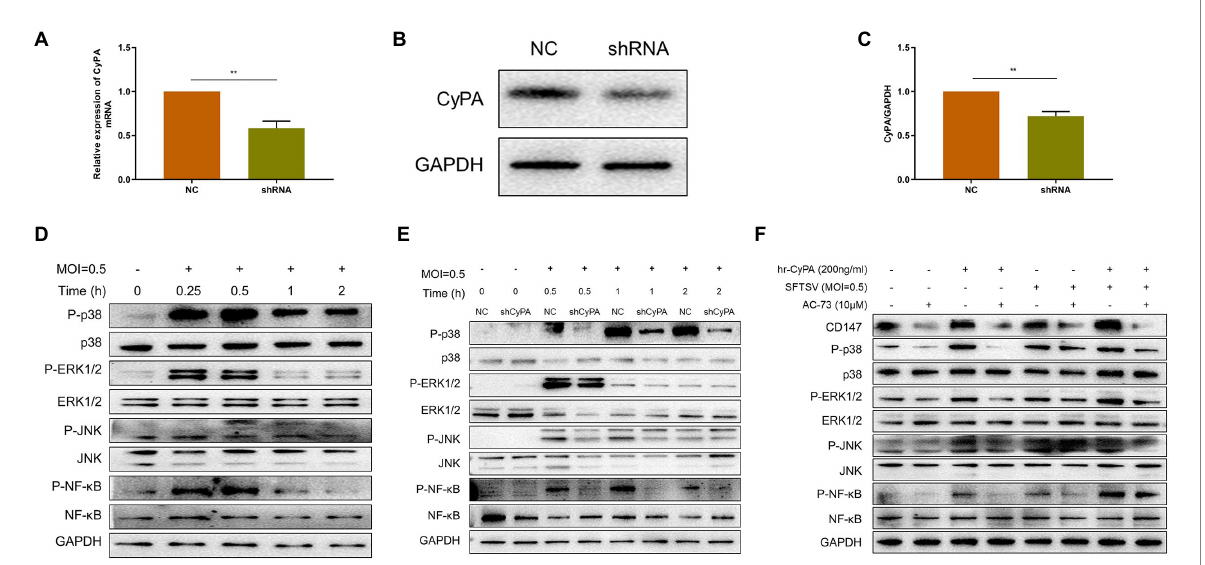
FIGURE 3 Extracellular CyPA binds to CD147 to activate the MAPK pathway in SFTSV-infected THP-1 cells. (A) The expression of CyPA mRNA as detected by qRT-PCR in THP-1 cells transfected with the sh-CyPA, compared with NC cells. (B) The CyPA protein level as detected by Western blot in sh-CyPA compared with NC cells. (C) The gray value analysis of (B) . (D) Western blot analysis of the indicated proteins in SFTSV-infected THP-1 lysates. (E) WB analysis of the indicated proteins in SFTSV-infected sh-CyPA and NC cell lysates at different times. (F) THP-1 cells were divided into blank group, AC-73 treated 4 h group, SFTSV or hrCyPA treated 0.5 h group, and co-treatment groups. Total cell lysates of each group were extracted for WB. (A,C) The values shown indicate the mean ± standard error of three independent experiments. ** p < 0.01. (D–F) One representative experiment is